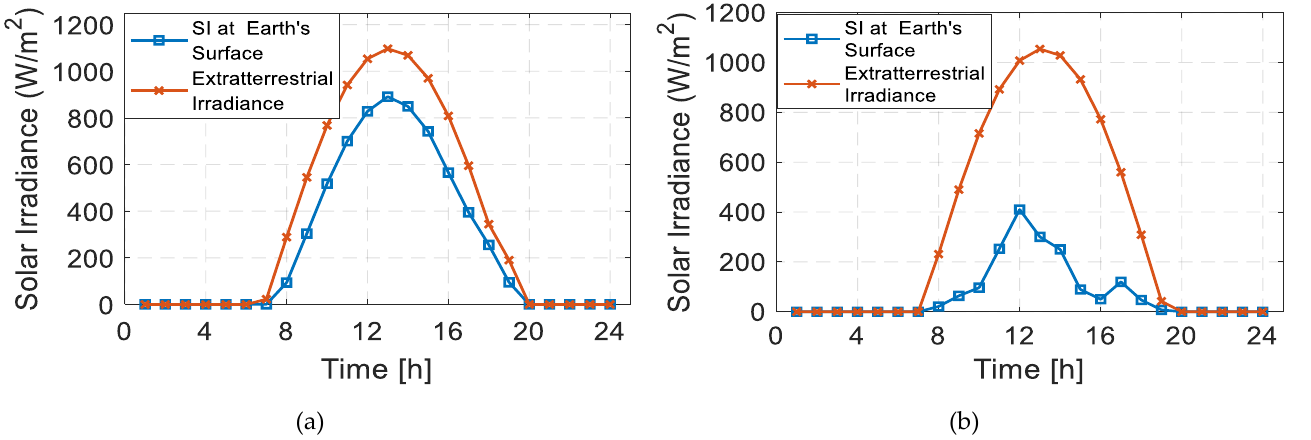
Figure 2. Example of ( a ) a sunny day and ( b ) a cloudy day for Golden, Colorado (USA).